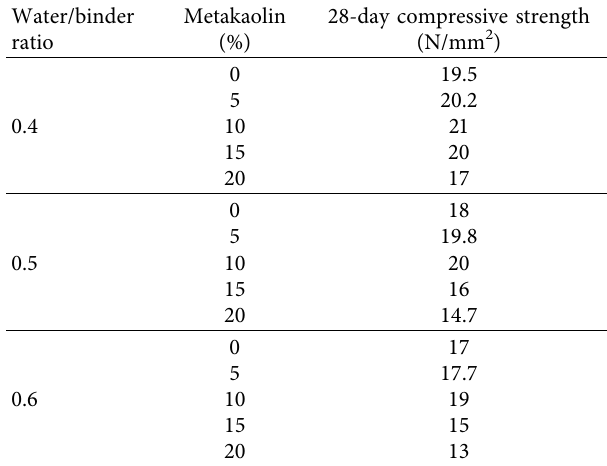
Table 6: Compressive strength of metakaolin concrete for grade